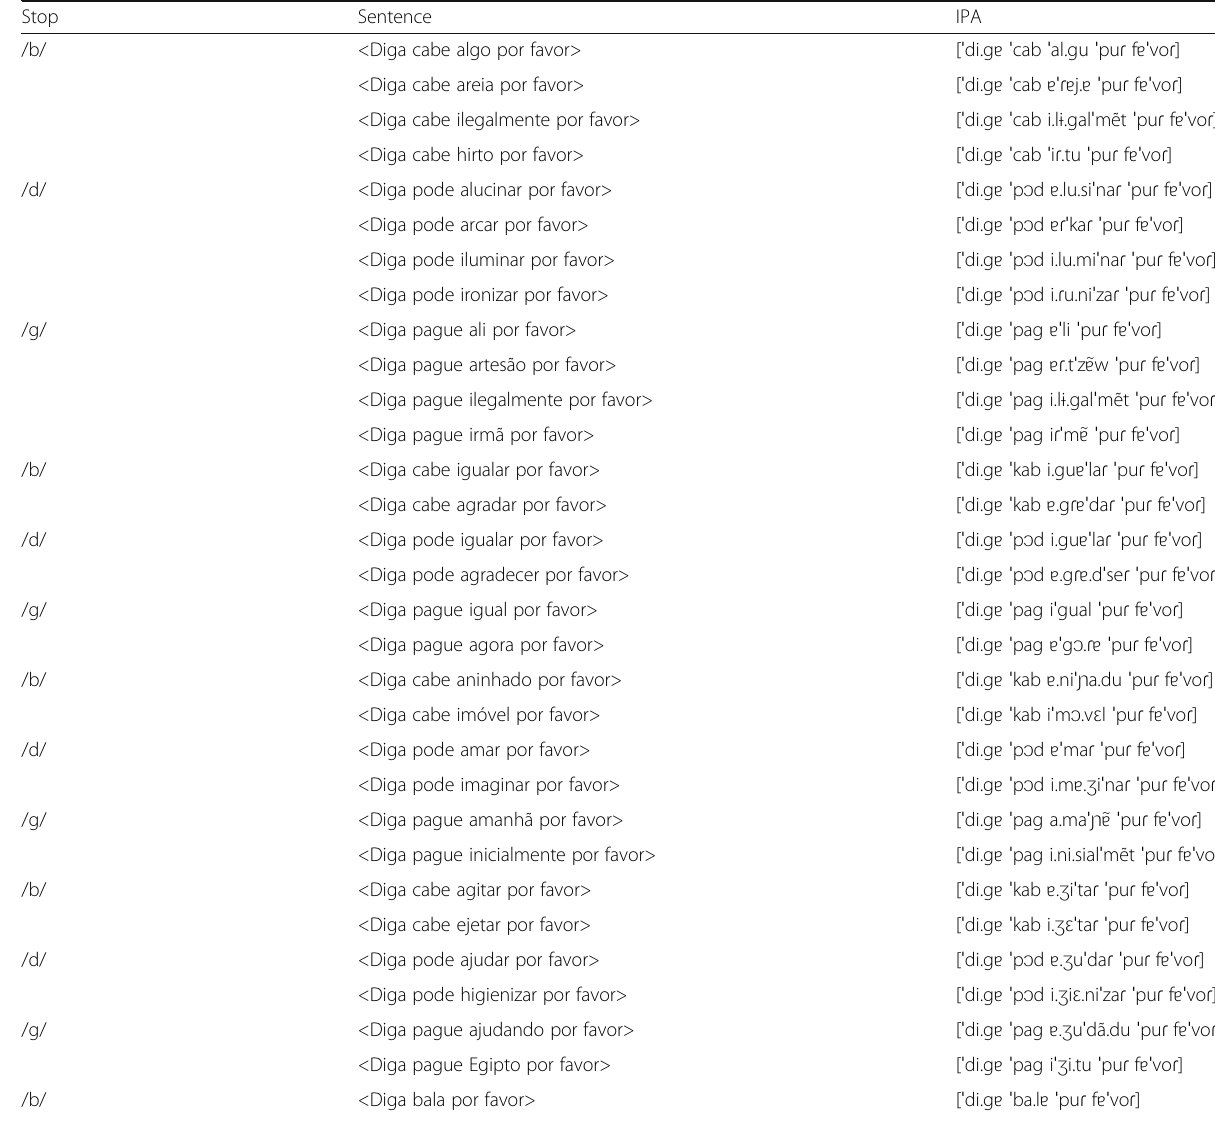
Table 15 Corpus of voiced stops: words in frame